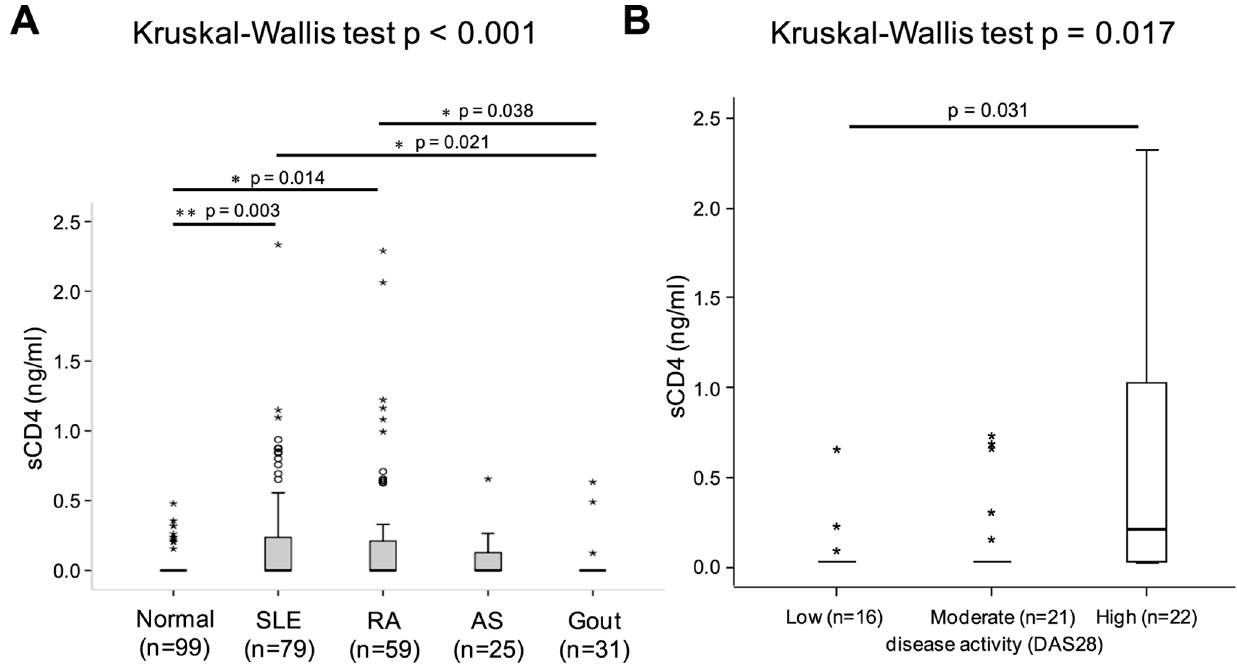
Figure 4. Comparison of serum sCD4 levels in various chronic inflammatory diseases. (A) Serum sCD4 levels in normal subjects groups, SLE, RA, AS, and gout. Data are shown as box plots. Each box represents the 25th to 75th percentiles. Lines inside the boxes represent the median. Lines outside the boxes represent the 10th and the 90th percentiles. Circles and asterisks indicate outliers and extreme values, respectively. Kruskal- Wallis test across all five groups shows p , 0.001. Only significant Dunn’s multiple comparisons post-test p values between groups are shown. (B) Comparison of serum sCD4 levels in RA patient groups classified by DAS28 as low-disease, moderate-disease, and high-disease activity. Data are shown as box plots. Each box represents the 25th to 75th percentiles. Lines inside the boxes represent the median. Lines outside the boxes represent the 10th and the 90th percentiles. Asterisks indicate extreme values. Kruskal-Wallis test across all three groups shows p=0.017. Only significant Dunn’s multiple comparisons post-test p values between groups are shown.